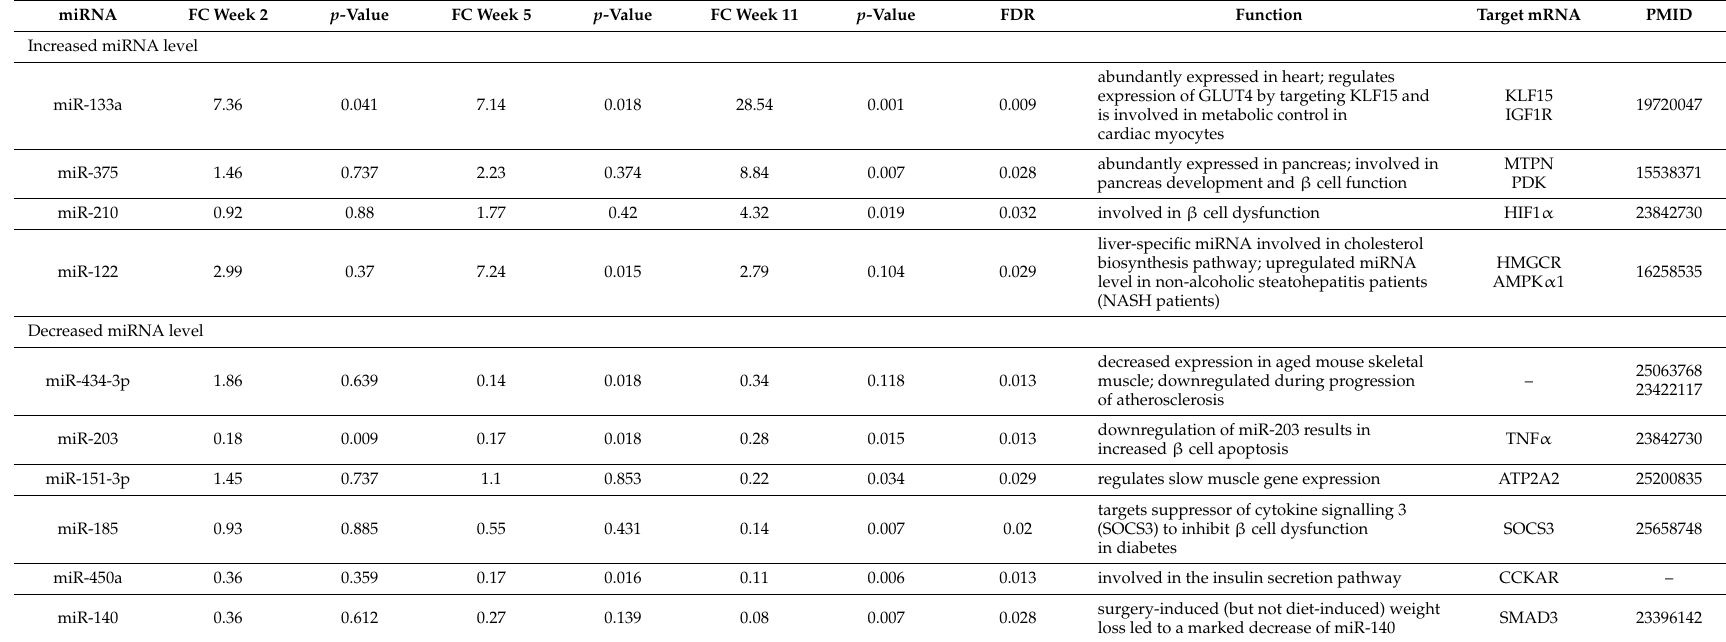
Table 1. Pathophysiological roles of deregulated